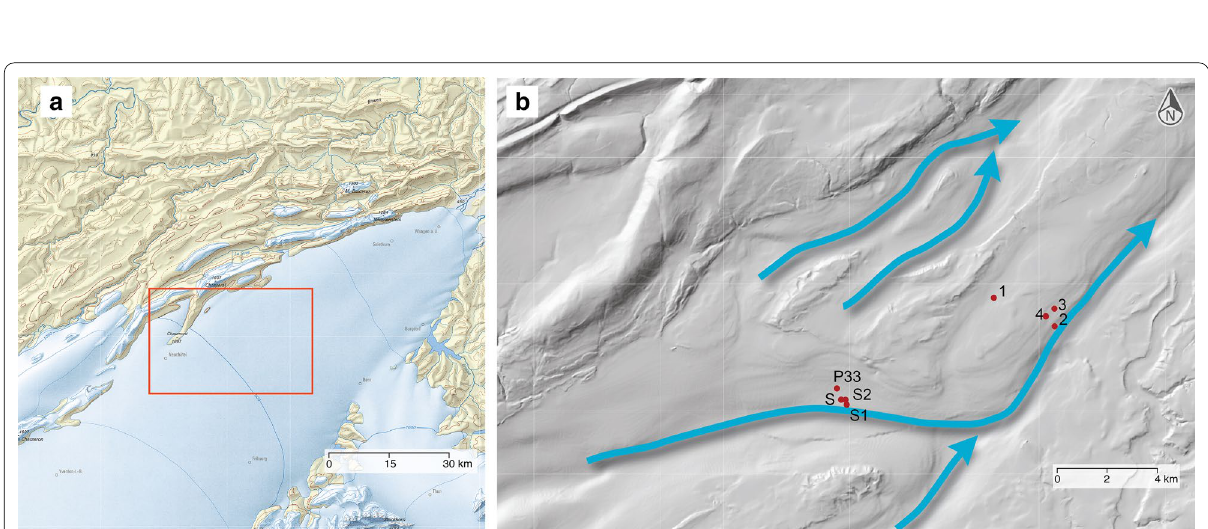
Fig. 2 a Extension of the Rhone-Aare-glacier system during the Last Glacial Maximum (LGM) in the study area. b Detail of the map ( a ) with topographic hillshade of the bedrock (bedrock elevation model) showing the former melt-water channels (blue arrows; Source: swisstopo) together with investigated profiles (for details, see Fig.